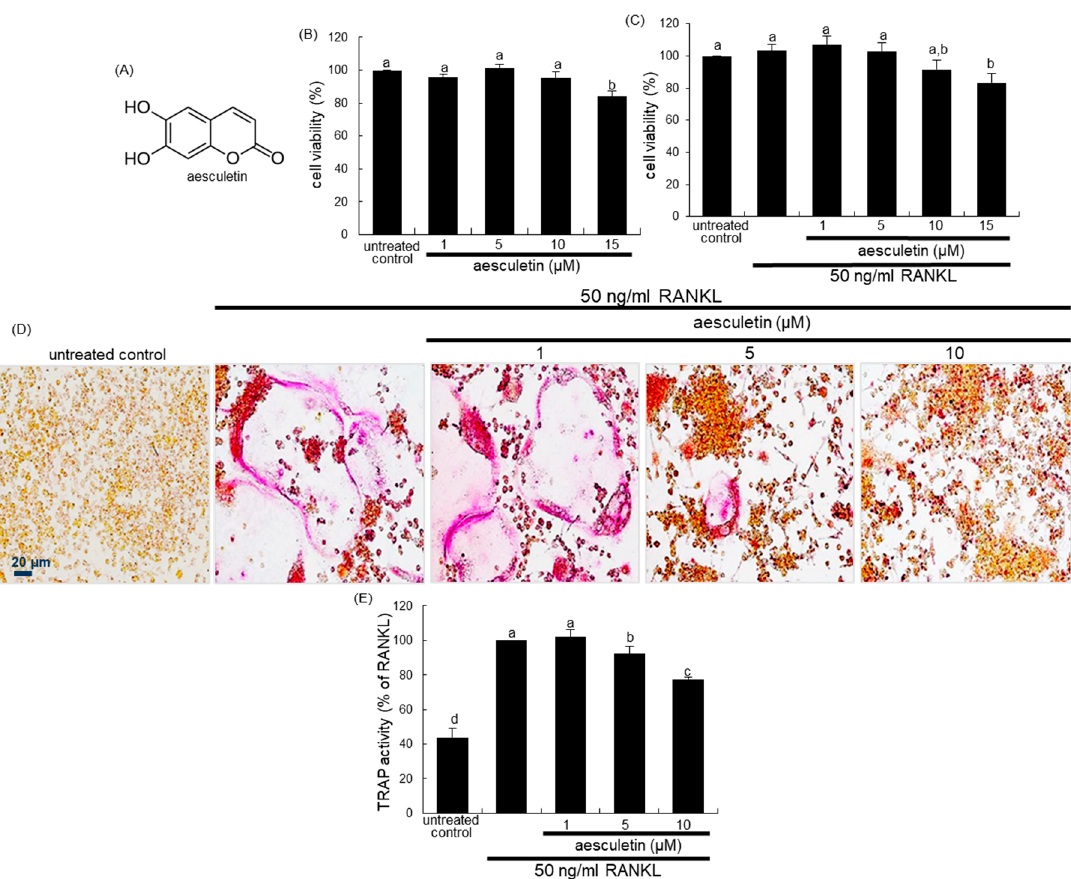
Figure 1. Chemical structure of aesculetin ( A ), cytotoxicity of Raw 264.7 macrophages by 1–15 µ M aesculin in the absence ( B ) and presence of receptor activator of nuclear factor- κ B ligand (RANKL) ( C ), and inhibitory e ff ects of aesculetin on tartrate-resistance acid phosphatase (TRAP) staining ( D ) and TRAP activity ( E ). Raw 264.7 cells were cultured for 3 days with 1–15 µ M aesculetin in the absence and presence of 50 ng / mL RANKL. Cell viability was measured by 3-(4,5-dimetylthiazol-yl)-diphenyl tetrazolium bromide (MTT) assay ( B , C ). Bar graphs for viability (mean ± SEM, n = 3) are expressed as percentage cell survival compared to untreated cells. For the TRAP staining and activity ( D , E ), Raw 264.7 cells were cultured for 5 days with 50 ng / mL RANKL in the absence or presence of 1–10 µ M aesculetin. TRAP-positive multinucleated osteoclasts were observed under light microscopy (four separate experiments). Scale bar = 20 µ m. TRAP activity (mean ± SEM, n = 3) was measured at λ = 405 nm. Respective values in bar graphs not sharing a small letter are significantly di ff erent at p < 0.05.